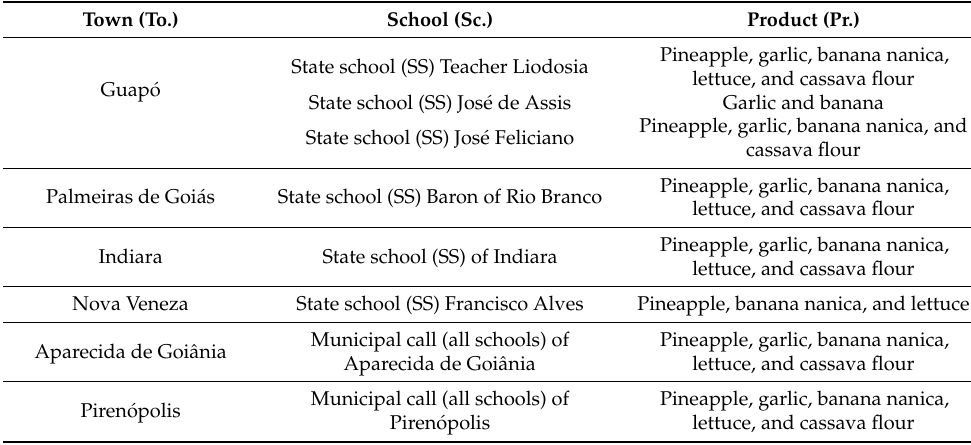
Table 1. Products, schools, and towns considered in the current application. Town